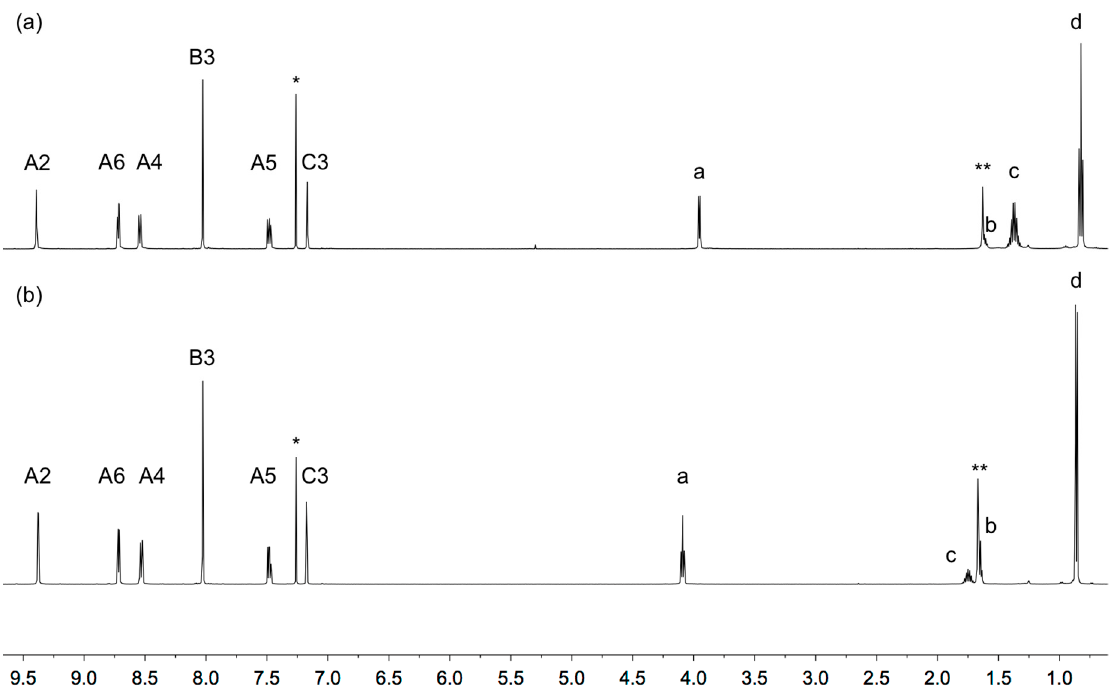
Figure 1. 1 H NMR (500 MHz, CDCl 3 , 298 K) of ( a ) 1 and ( b ) 2 . Chemical shifts in δ /ppm. * = CHCl 3 , ** = water.